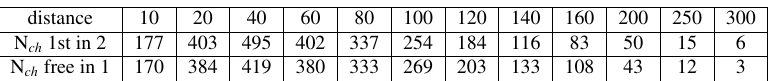
Table 1. Charged secondaries in two groups